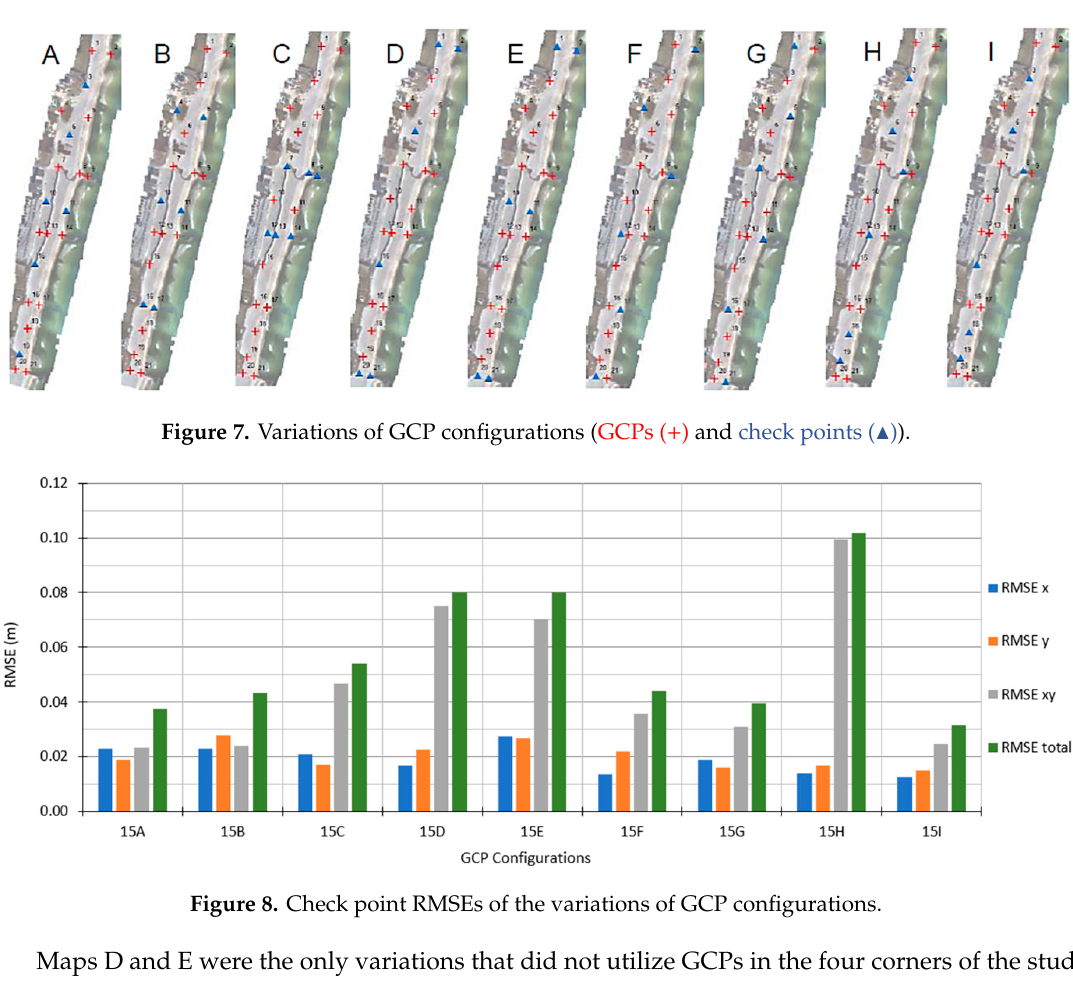
Figure 9. GCP Configurations for variation H and variation I (GCPs (+) and check points ( ▲ )).